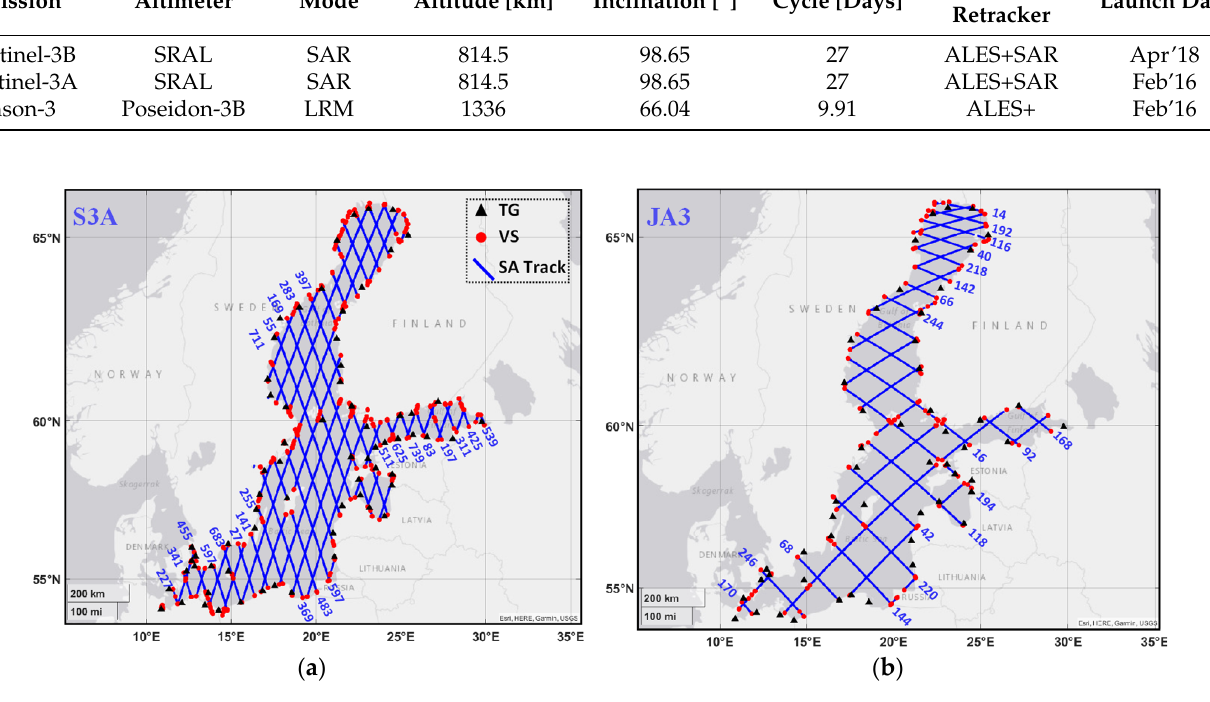
Figure 7. Coverage of SA passes within the study area. ( a ) Sentinel 3A (note that S3B has almost the same track patterns) and ( b ) Jason-3 missions. For each mission ascending pass numbers are shown. The locations of VS and TG stations are denoted by red circles and black triangles, respectively. Table 2. The used SA missions and their main speci fi cations.